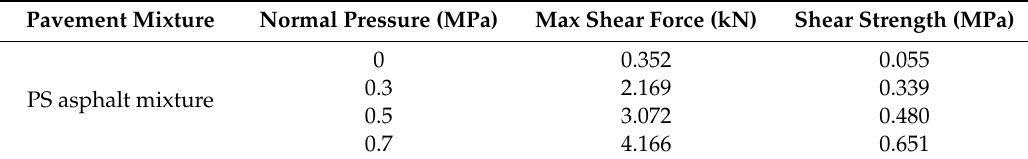
Table 5. Test results of interlaminar shear strength under di ff erent normal pressures.